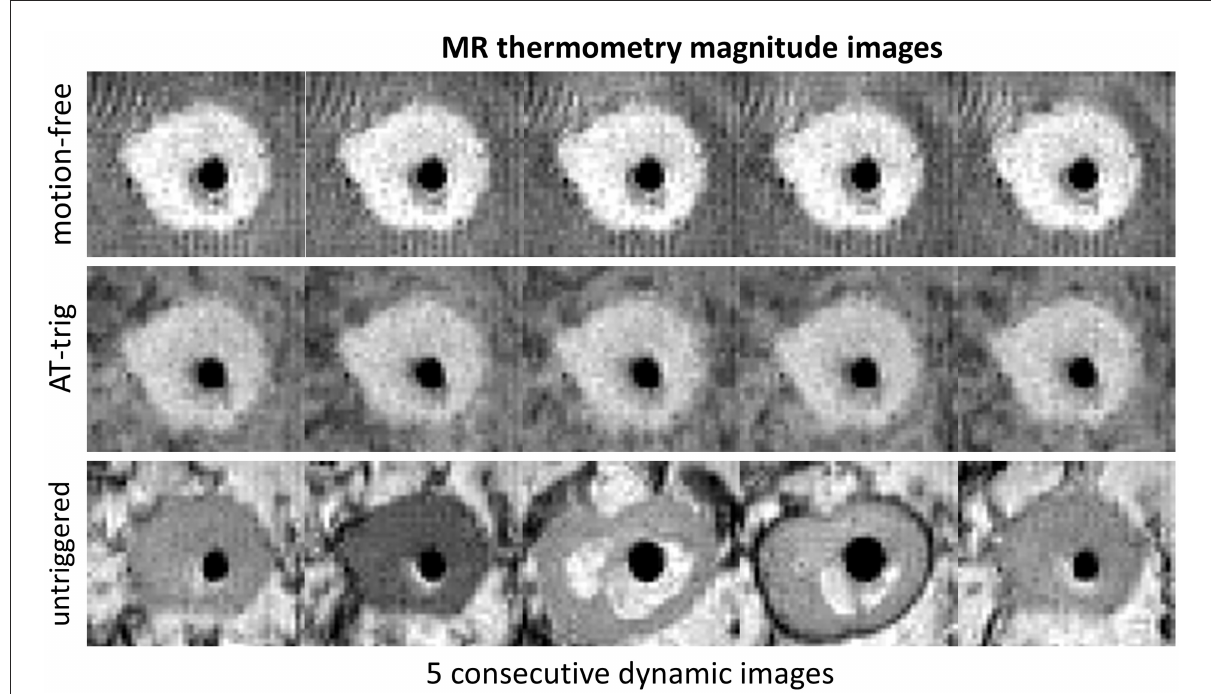
FIGURE3 Magnitude images of MR thermometry acquisitions of an apical axial slice of the phantom during the motion-free, AT-trig, and untriggered experiments. The phantom material can be seen as a roughly circular shape with higher signal intensity compared to the darker signal of the water surrounding it. The signal void in the center of the phantom is the piston that drives it into motion. The phantom shape in the images acquired with AT-trig matches the motion-free images, indicating successful triggering. Without triggering, the phantom shape varies under the influence of